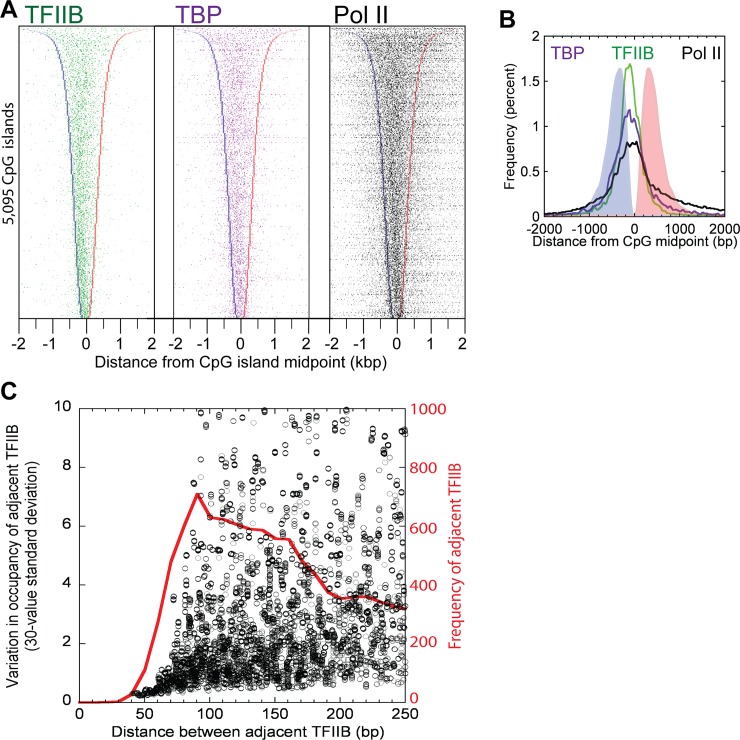
Distribution of the TFIIB/TBP/Pol II in CpG islands that overlap mRNA TSSs.(A) Peak-pair distribution for TFIIB, TBP and Pol II at the 5,095 CpG islands that overlap with the 6,511 mRNA TSSs from Fig 1B (78% overlap), and with the direction of transcription to the right. Rows are linked, and sorted by CpG island length. CpG island left and right borders are indicated by blue and red bars, respectively. (B) Shown is the averaged data from panel A. (C) TFIIB locations were sorted by location, and inter-TFIIB distances calculated (red trace). Data were then sorted by distance, and the standard deviation of TFIIB occupancy was calculated on a sliding window of 30 values. Peak calling parameters preclude detection of two separate TFIIB locations <~40 bp apart. Those that were 40–70 bp apart were correlated, whereas those >~70 bp apart were uncorrelated.